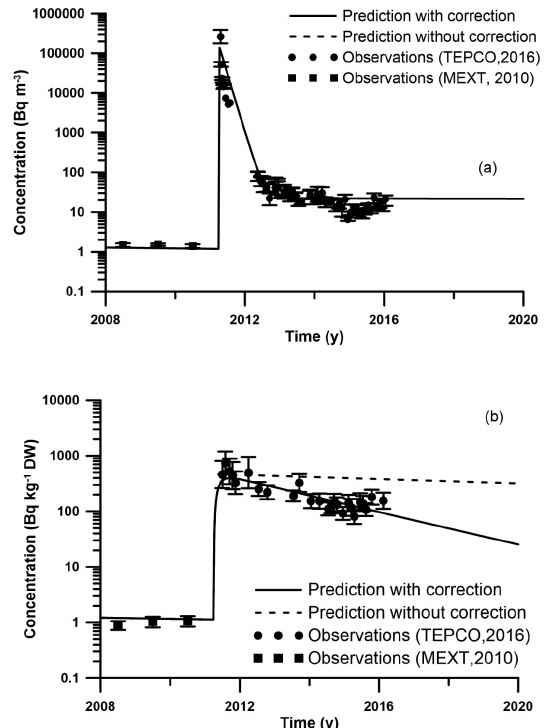
Figure 3. Comparison between calculated and observed 137 Cs con- centration in seawater (a) and in bulk bottom sediment (b) in the coastal box around the FDNPP. Values in (b) are given in becquerels (Bq) per kilogram (kg) of dry weight (DW). The dashed line in (b) shows results of simulations using standard POSEIDON-R model, whereas the solid line presents simulation with the correction term in Eq.